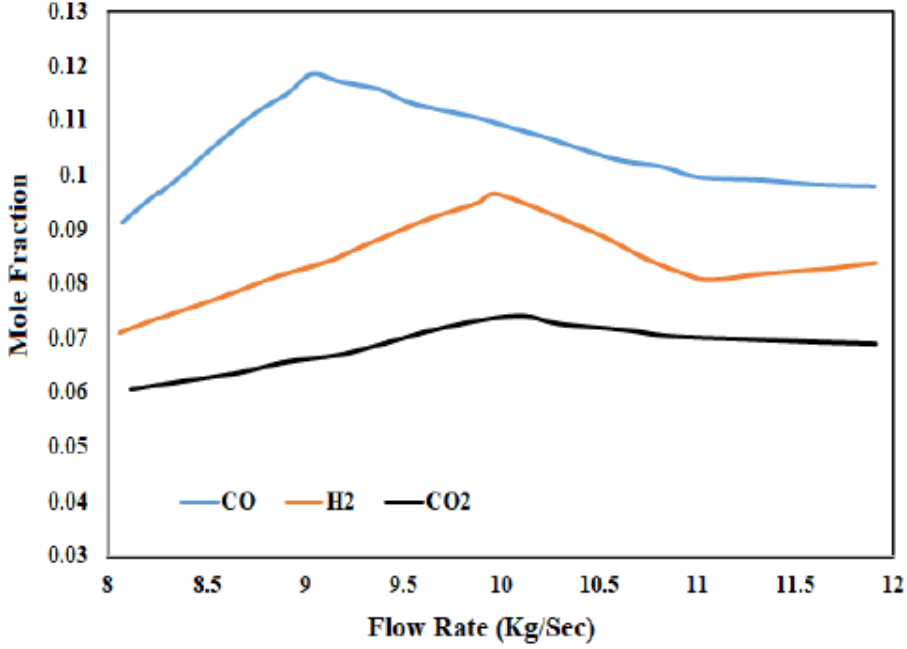
Figure 4. Syngas fraction of Thar lignite coal.